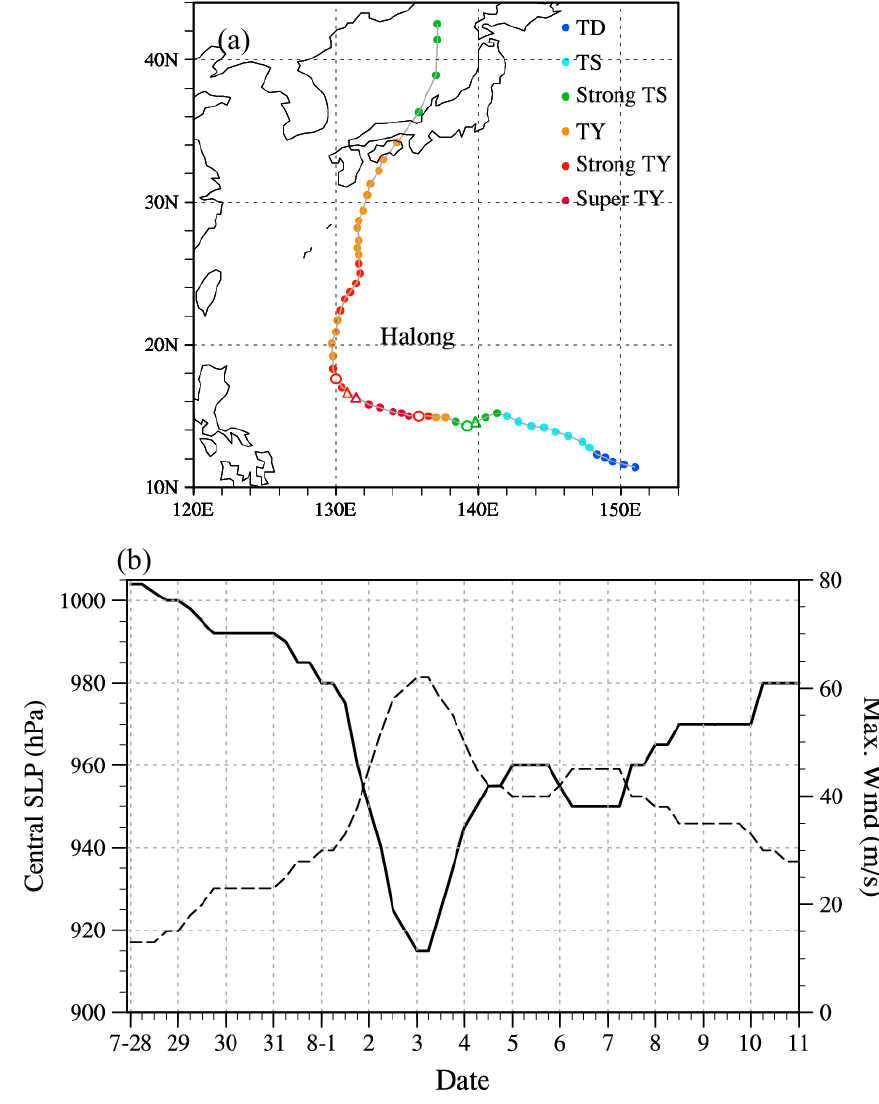
Figure 16. ( a ) The best track and ( b ) central sea-level pressure (SLP; solid) and maximum sustained surface wind speed (dashed) of Typhoon Halong from 0000 UTC 28 July to 0000 UTC 11 August 2014. The open circles and triangles in (a) indicate select AMSU-A and MWTS-2 cases, respectively.